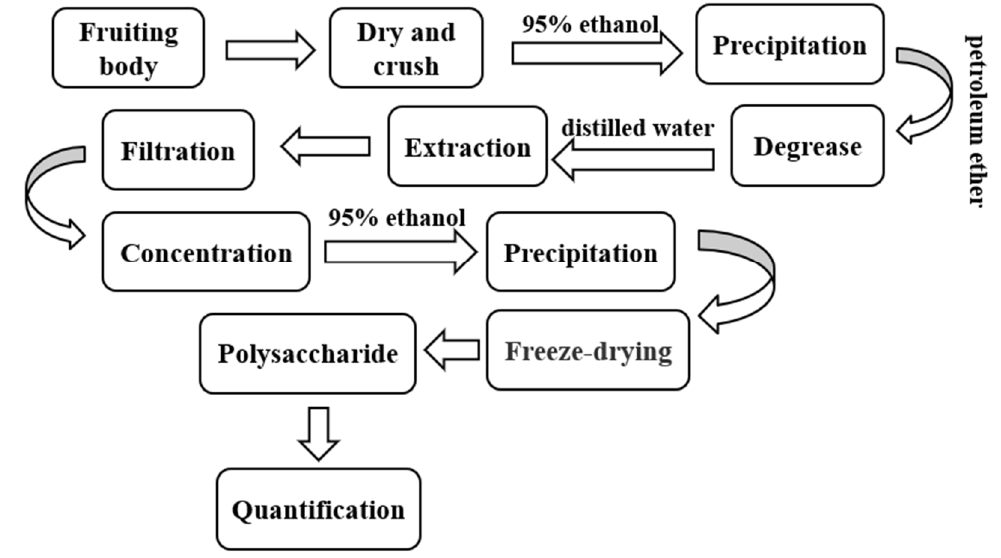
Figure 2. Flow chart of extracting Ganoderma lucidum p olysaccharide.